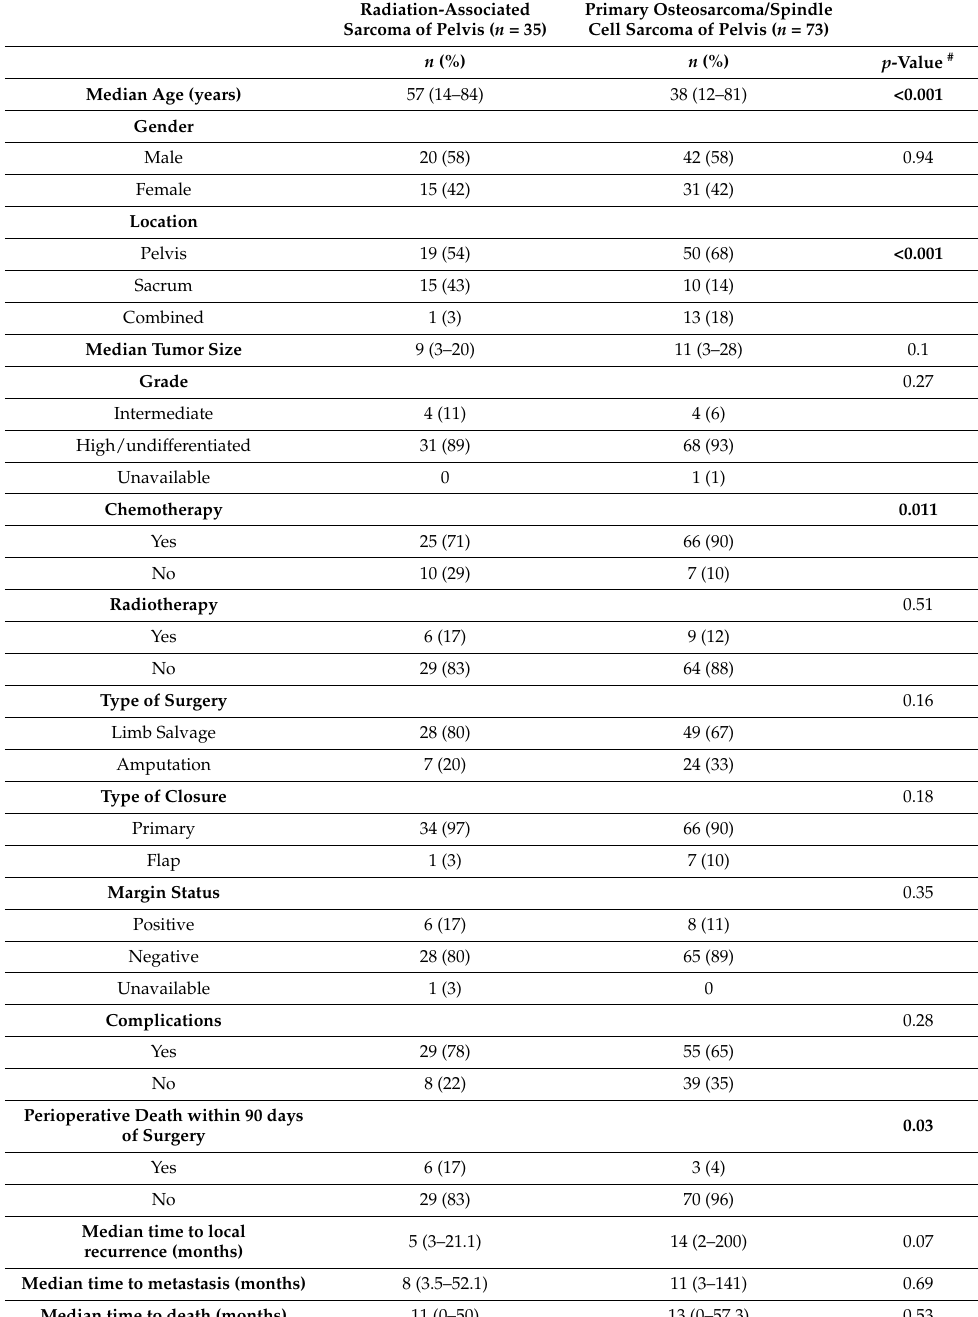
Table 2. Patient, tumor, and treatment differences between radiation-associated sarcoma of the pelvis and sacrum and primary osteosarcoma/spindle cell